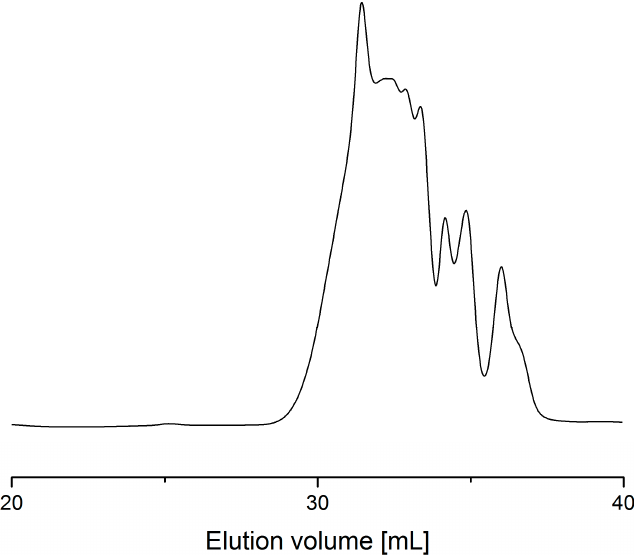
Figure 4. GPC eluogram of glycerol oligomers obtained with K 2 CO 3 (4 wt %) as a catalyst with the microwave optimized process.